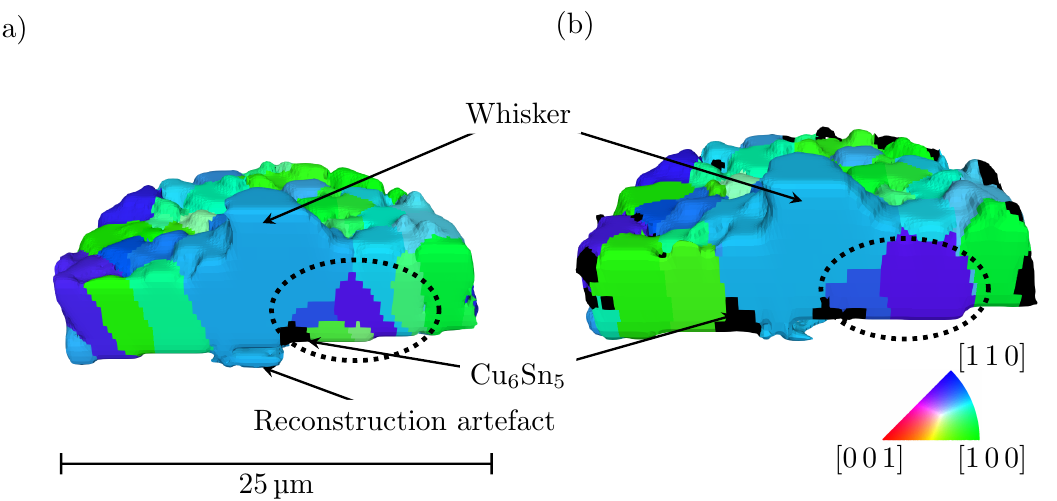
Sn -grains situated below the whisker. The grains 6 5